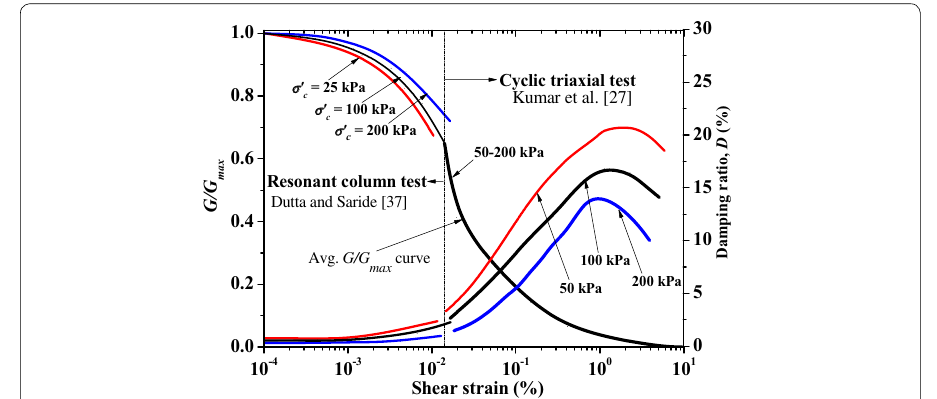
Fig. 14 Strain-dependent G/G max and D for cohesive RS soil [27,